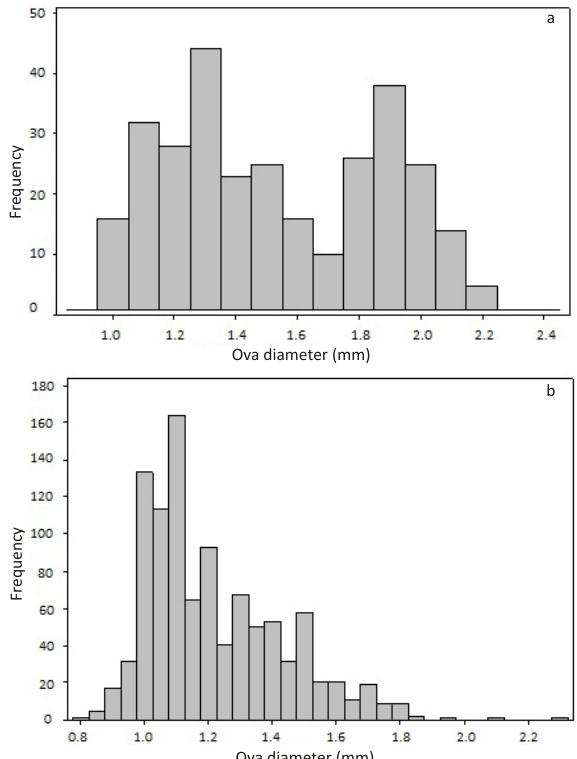
Figure 7. Ova diameter frequency histograms of (a) Garra regressus and (b) G. tana from Lake Tana